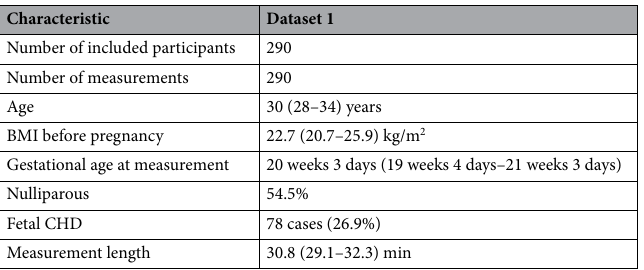
Table 1. Characteristics of Dataset 1. Where applicable, values are presented as median and interquartile